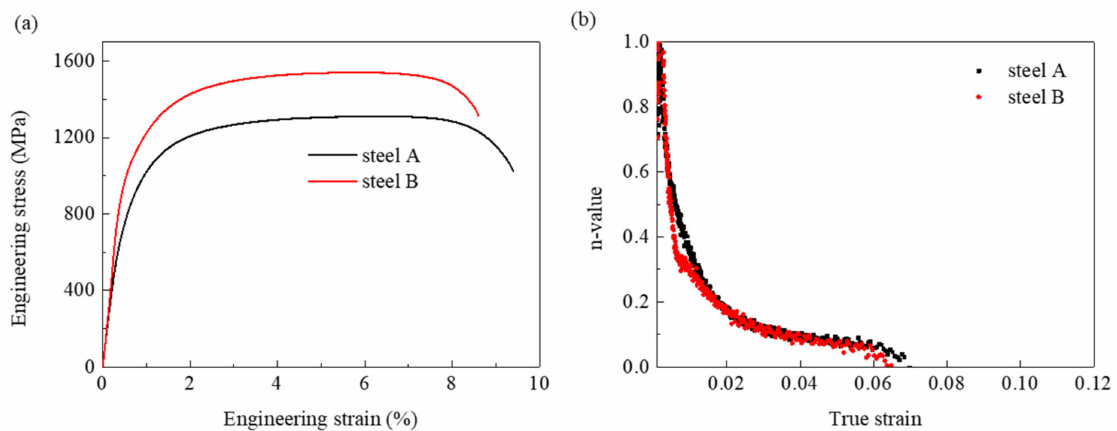
Figure 18. ( a ) Engineering stress versus strain and ( b ) n -value versus true strain of steel A and B under flash